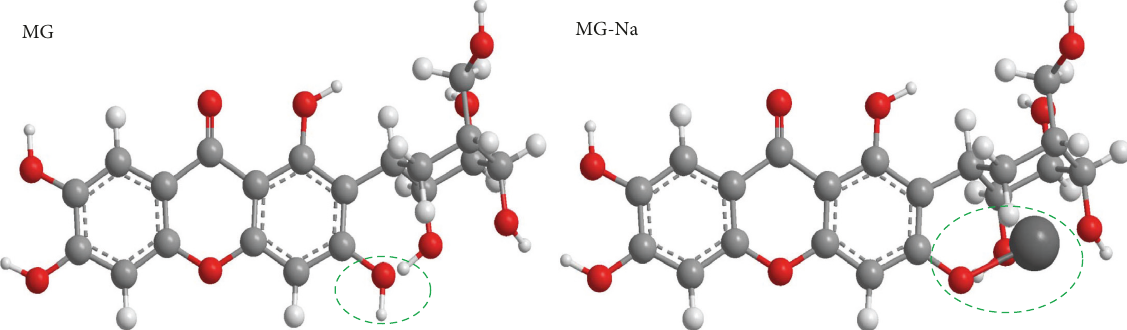
Figure 1: Chemical structure of MG and